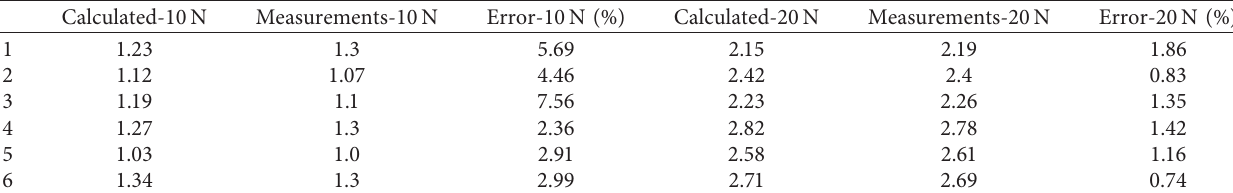
Table 4: Comparison of cable deformation.